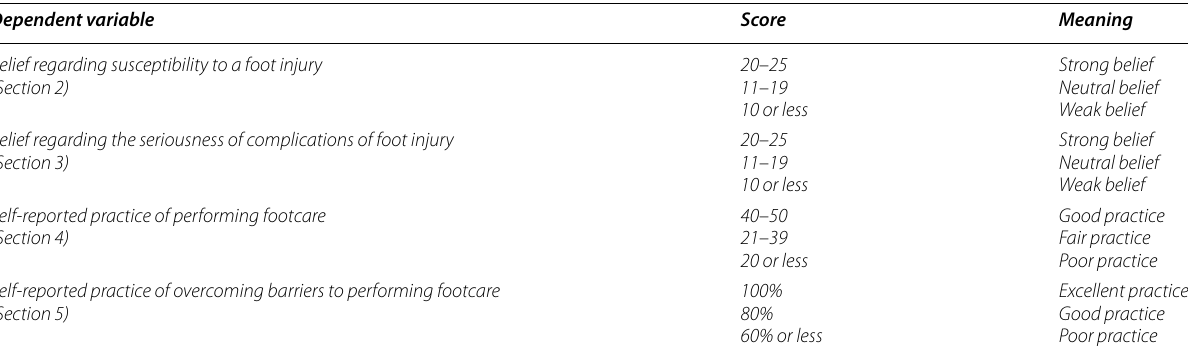
Table 1 Categorization of scores Dependent